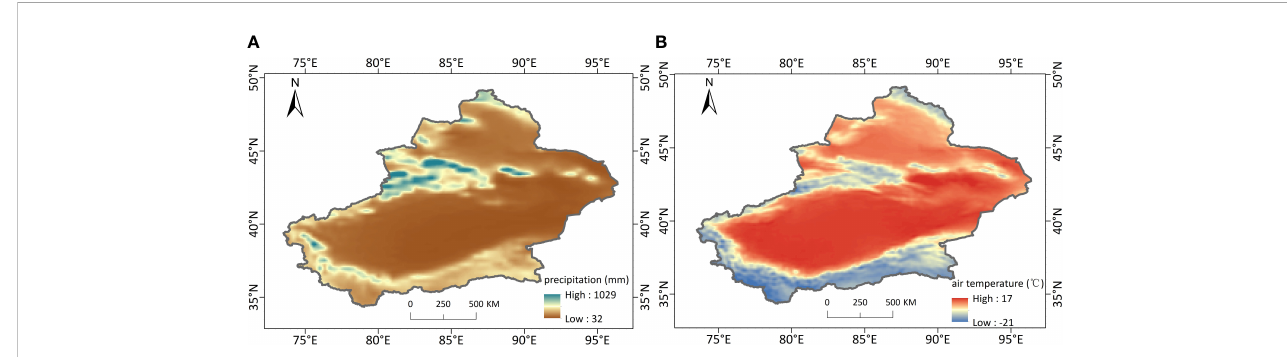
FIGURE 6 Spatial distributions of 20-year mean annual precipitation (A) and air temperature (B) over Xinjiang from 2001 to